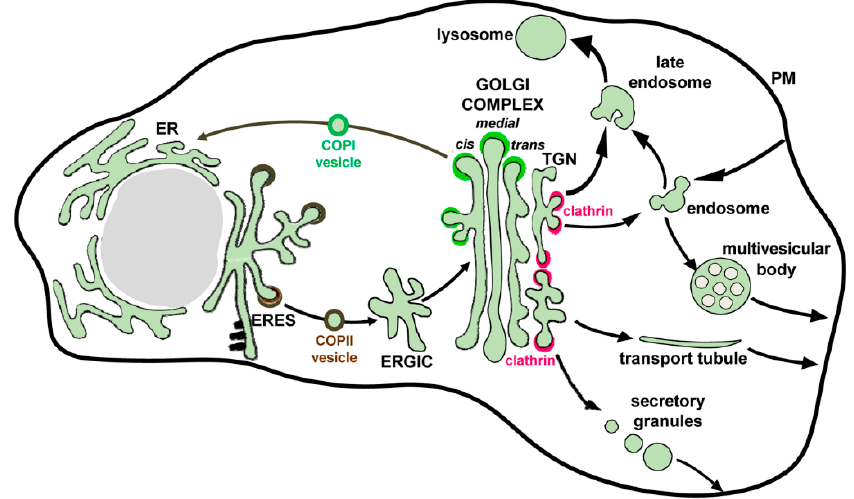
Figure 2. Compartments of the secretory pathway. Transport steps are indicated by arrows. Secretory cargos are synthesized in the ribosome-studded ER, exit the ER at ERES in COPII-coated (brown) vesicles and are transported to the ER-Golgi compartment (ERGIC) and then to the Golgi. After passage through the Golgi complex in the cis-to-trans direction, cargos are packaged at the TGN for delivery to the PM, early and late endosomes and in some cells to secretory granules. Sorting into endosomal compartments and secretory granules is mediated by clathrin-coated (red) vesicles. Transport to the PM is mediated by transport tubules. A COPI-mediated (green) recycling pathway retrieves escaped proteins from the ERGIC and the Golgi and returns them to the ER. Multivesicular bodies form by invaginations of endosomal membrane into its lumen and can fuse with the PM to release their content of exosomal vesicles.